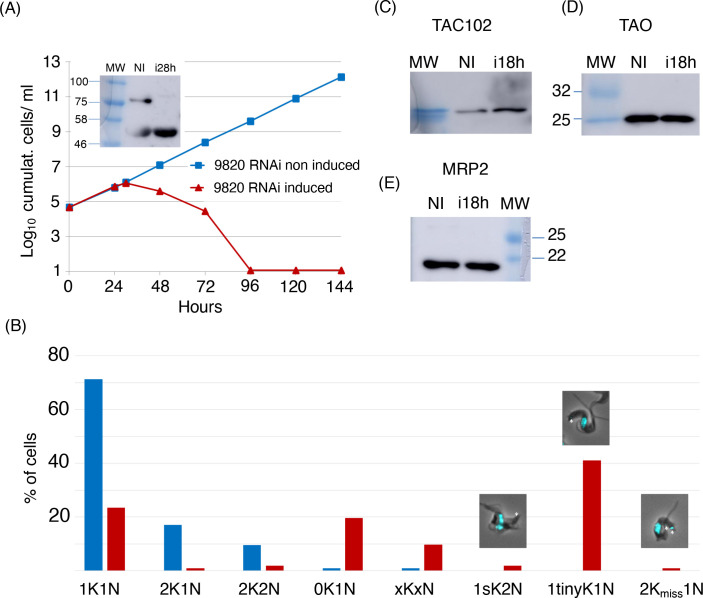
Characterisation of MIP RNAi cell line (BSF) (gene: Tb927.10.9820).(A) Growth curves of MIP RNAi cell line with induction (red) and without induction (blue) with tetracycline (n = 1). MIP was C-terminally Myc-tagged in the RNAi cell line. The fusion protein was expected at 80 kDa. The RNAi efficiency was assessed by western blot using an anti-Myc antibody (rabbit). The upper band corresponded to MIP-Myc. The lower band was an unspecific band detected by the antibody. (B) Cell cycle status of MIP RNAi cells (BSF) with (red) and without (blue) induction of RNAi for 24 h. Around 100 cells were observed per condition (non-induced and induced, n = 1). Exemplary composite pictures are shown on top of the columns for “1K2N small K”, “1K1N tiny K” and “2K1N misseg” categories. The kDNAs are indicated with white arrows. (C) Western blot of MIP RNAi cell line probed for TAC102. A 3.5% gel was used. (D) Western blot of MIP RNAi cell line probed for TAO. A 12% gel was used. (E) Western blot of MIP RNAi cell line probed for MRP2. A 12% gel was used. kDa: kilodalton; MW: molecular weight; NI: RNAi non-induced; i28h: RNAi induced during 28 h. n = 1 for all experiments.